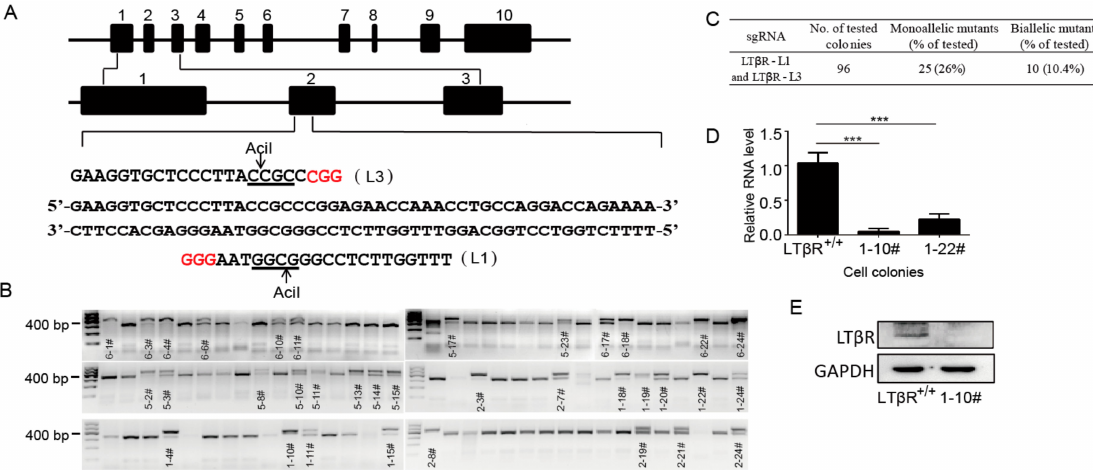
Figure 2. Generation and identification of LT β R knockout intestinal porcine enterocyte (IPEC-J2) cells. ( A ) Targeting strategy: two different small guide RNAs (sgRNAs) (L1 and L3) targeting 32 bp regions of exon 2 in the pig LT β R gene were designed and inserted into the pX330 vector. Then, the pCAG-GFP plasmid was co-transfected with the pX330-L1 and pX330-L3 plasmids, and single cells were sorted into 96-well plates by flow cytometry. ( B ) A total of 96 colonies were picked and subjected to RFLP analysis. Monoallelic and biallelic mutant clones were labeled by their clone number. ( C ) Estimation of targeting efficiency. Note that 10 biallelic mutated clones were identified, and the targeting efficiency was 10.4%. ( D ) Wild-type IPEC-J2 cells and two biallelic mutated clones (namely 1-10# and 1-22#) were picked for real-time PCR analysis. *** p < 0.001 was considered statistically significant. Note that the expression levels of LT β R were significantly decreased in 1-10# and 1-22# cells ( p < 0.001 respectively). ( E ) LT β R protein levels in the wild-type and 1-10# cells were detected by immunoblotting with an anti-LT β R antibody at a 1:1000 dilution (Abcam). GAPDH was used as a loading